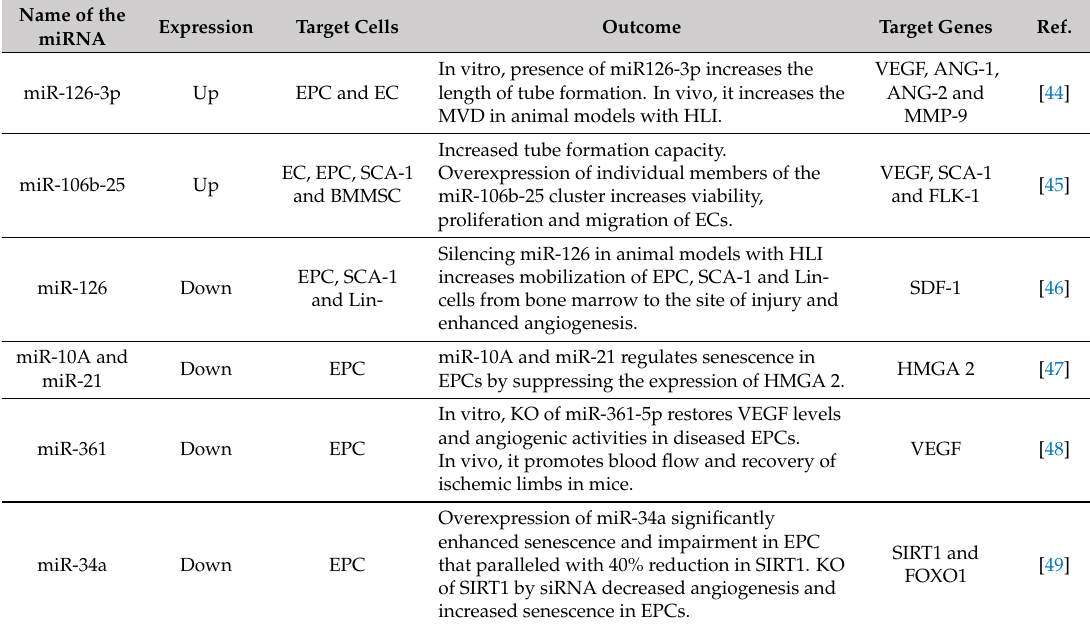
Figure 2. Sonic Hedgehog (SHH) molecule or SHH secreted on extracellular vesicles (EVs) mediated functional improvement of endothelial progenitor cells (EPCs). In vivo, administration of exogenous SHH molecules increased vasculogenic EPCs. Transplantation of enhanced EPCs was beneficial for recovery in myocardial infarction (MI). Table 1. Summary of pro-angiogenic and anti-senescence micro-RNAs (miRNAs) in endothelial progenitor cells (EPCs) and endothelial cells